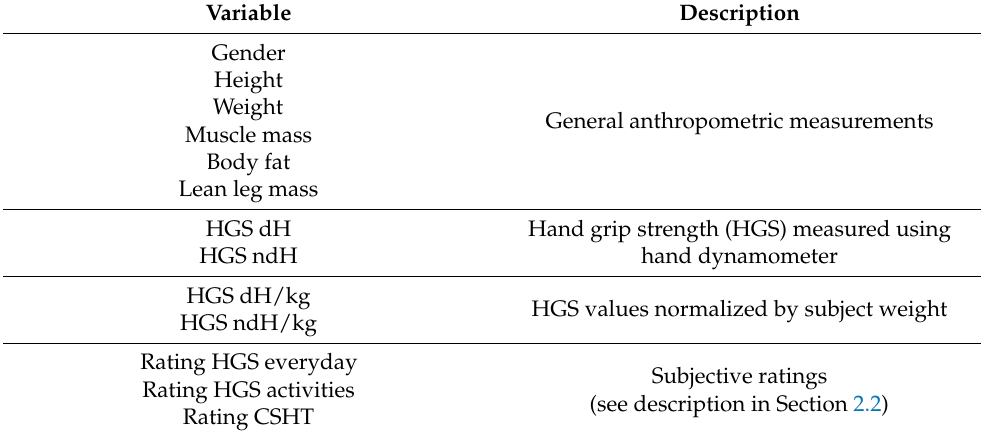
Table 1. Overview of the variables used as input features. dH = dominant hand; ndH = non-dominant hand.